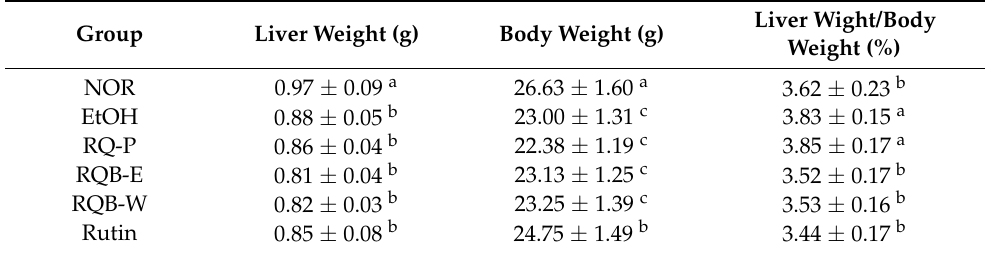
Table 2. The body weight, liver weight and liver weight/body weight ratio of the AFLD mice.